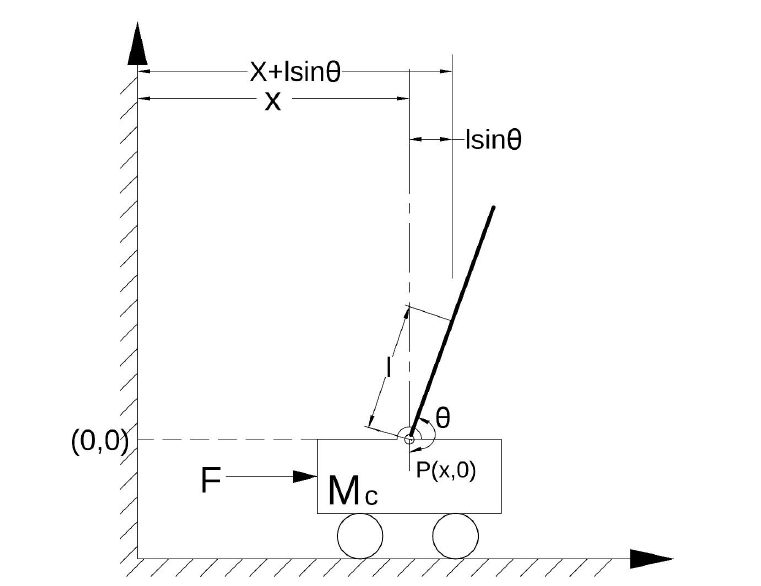
Figure 2. Pendulum cart system—analogous to the monowheel system.